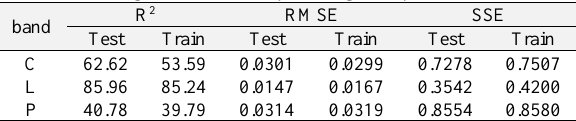
Table5. Results of SVR model with optimal features selection with SFS algorithm without optimizing SVR parameters